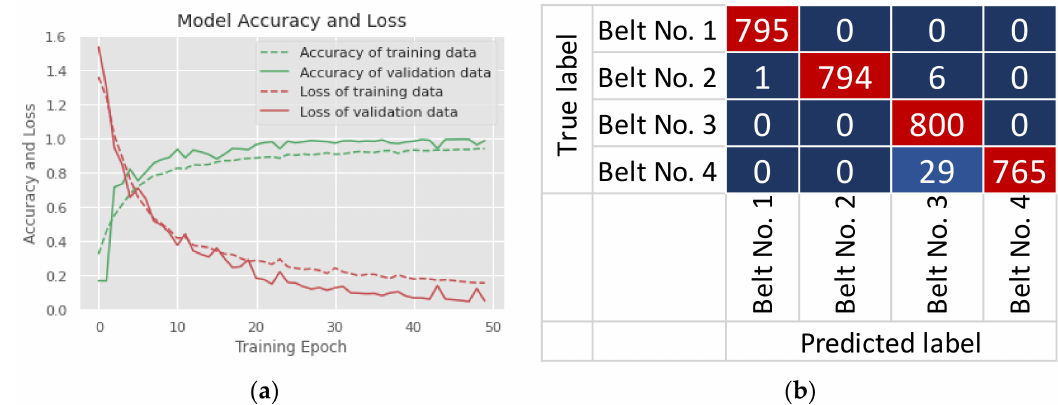
Figure 19. ( a ) Model accuracy and loss curves; and ( b ) confusion matrix of triple-axis vibration data (please see Table 2 for detailed information on classification label).